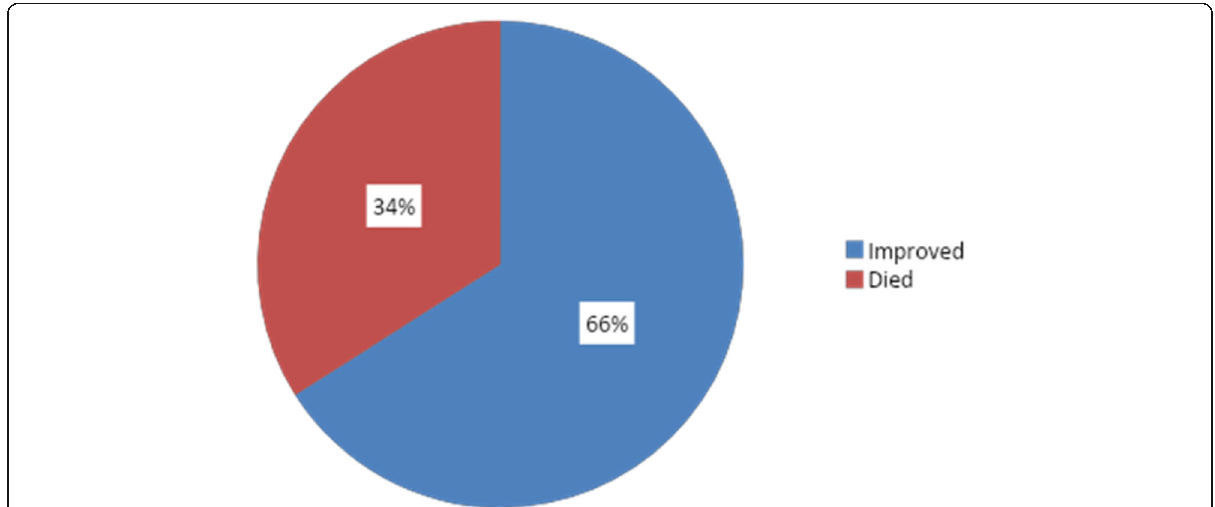
Fig. 1 Outcome of patients with